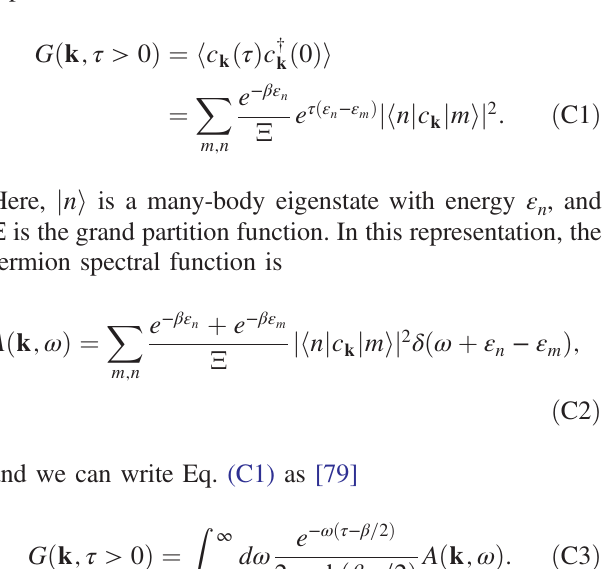
FIG. 21. Left-hand panels: The imaginary part of the inverse of the Matsubara Green function Im ½ G − 1 ð k F ; ω h ¼ 3 . 525 . Data points from different temperatures mostly lie on the same curve. Right-hand panels: The imaginary part of the self-energy. The dashed line in the bottom left-hand panel corresponds to Z ¼ 0 . 93